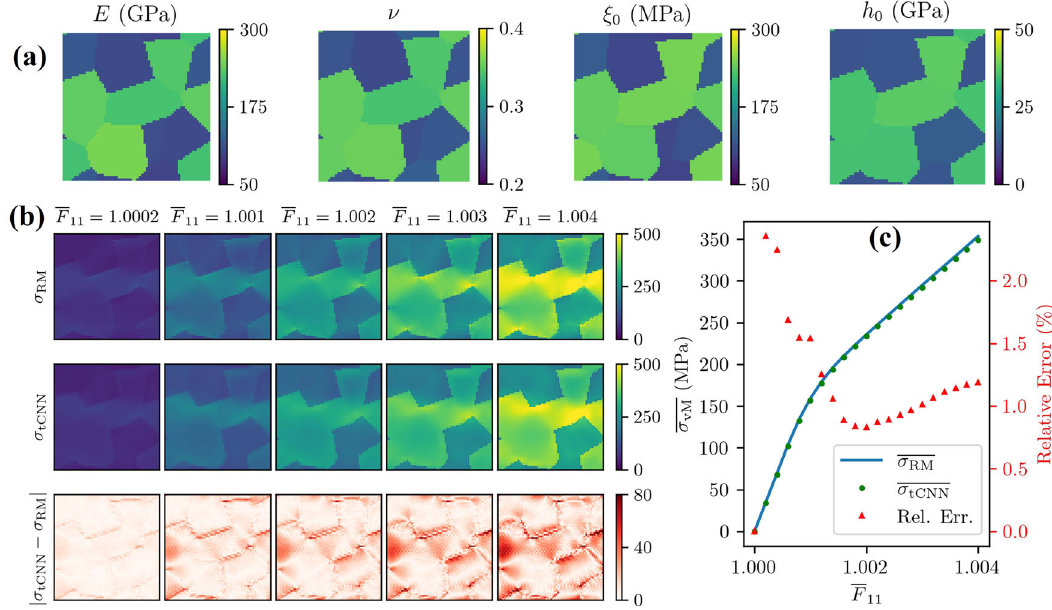
Fig. 5 Case 3 (low-contrast) test microstructure subject to uniaxial extension along the horizontal axis. a Young ’ s modulus E , Poisson ’ s ratio ν , initial fl ow resistance ξ 0 , linear isotropic hardening modulus h 0 . b Results for σ RM (above), σ tCNN (middle), ∣ σ tCNN − σ RM ∣ (below) (all MPa), at different F 11 . c σ RM (blue curve), σ tCNN (green points), and relative error (red triangles) given by 100 ð σ tCNN (cid:3) σ RM Þ = σ RM versus F 11 .